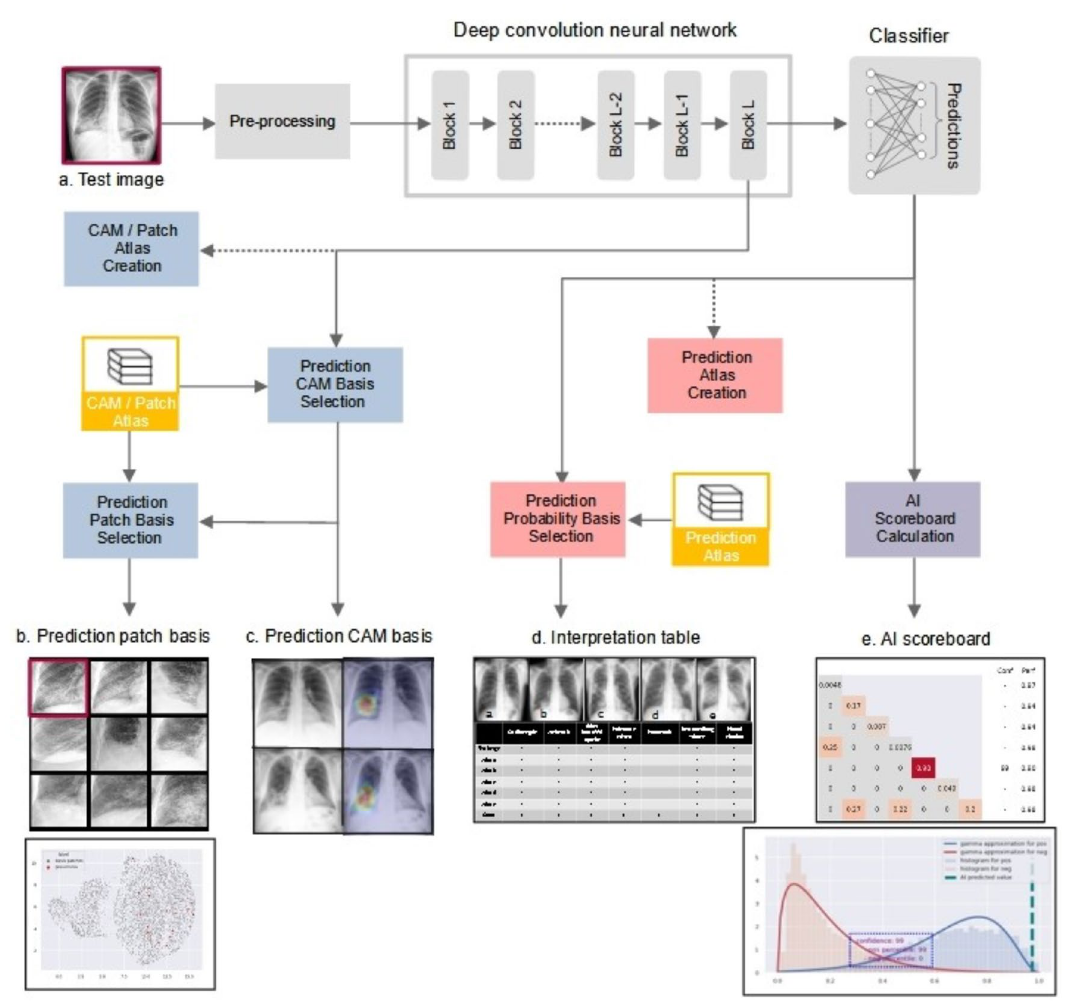
Figure 3. Schematic overview of CXR interpretation by our xAI model using a three-dimensional approach. The architecture of our CXR xAI model includes DenseNet-121 pre-trained DCNNs, ( a ) pipeline of pre- processing techniques, an Atlas creation module and prediction-based retrieval modules. The xAI model produces 3 types of outputs: (1) label prediction and attention map with corresponding feature patches selected from the Model-Derived Atlas ( b , c ). The first one on the upper left is a feature specific patch from the test CXR and the other eight are selected from the Atlas, which were closely located to the test patch on UMAP ( b ). The four CXR images were retrieved from the Atlas, which have similar overall characteristics with the test CXR ( c ). (2) an interpretation table displaying prediction probabilities for coexisting labels and comparable CXRs selected from the Model-Derived Atlas (d) , and (3) an AI scoreboard displaying prediction probabilities and calibrated classifier confidence, and histogram for AI prediction, positive and negative percentile ( e